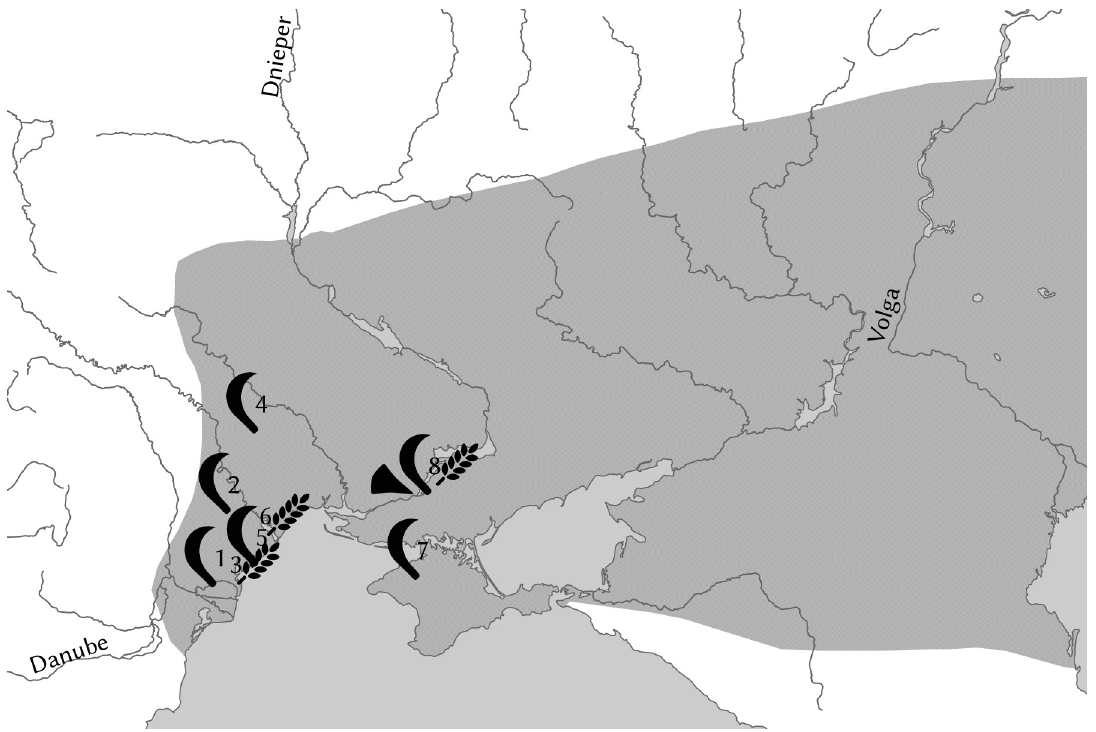
Fig 3. Cereal remains, cutting tools and a plowshare alleged to be found in Yamnaya contexts. The shaded area indicates the extent of the Yamnaya culture at the end of the Copper Age [18:651]. Sites: 1 Kholmske; 2 Gura-Bykuluy; 3 Glubokoe; 4 Tetskany; 5 Alkaliya; 6 Belyaevka; 7 Rysove; 8 Mikhailovka; 9 Skelya-Kamenolomnya. Cutting tool data from Razumov [162] and Ivanova [39], plowshare data from Gimbutas [214:161], and cereal data from Pashkevich [36:15] and Anthony